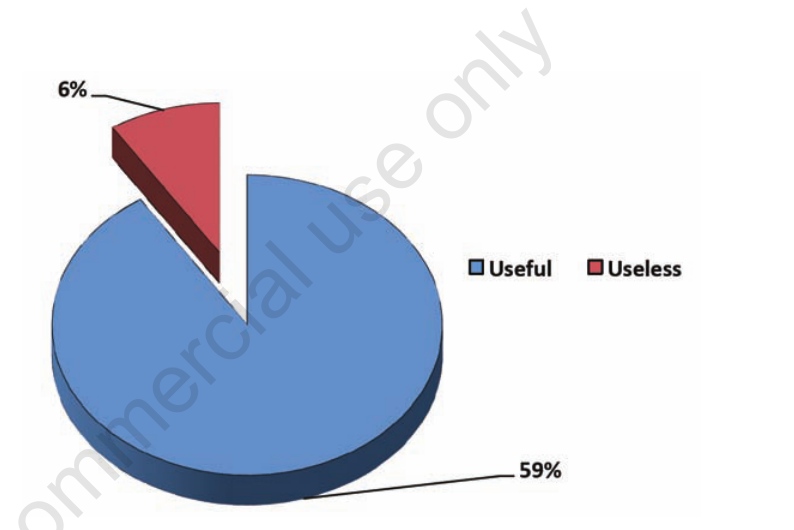
Figure 4. Usefulness of the figure of a psychologist at the Centre of Care (%).